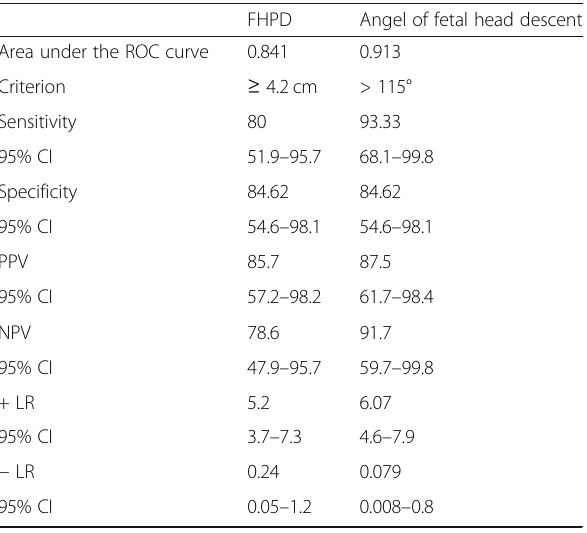
Table 2 Fetal complications detected by TPUS Fetal complications